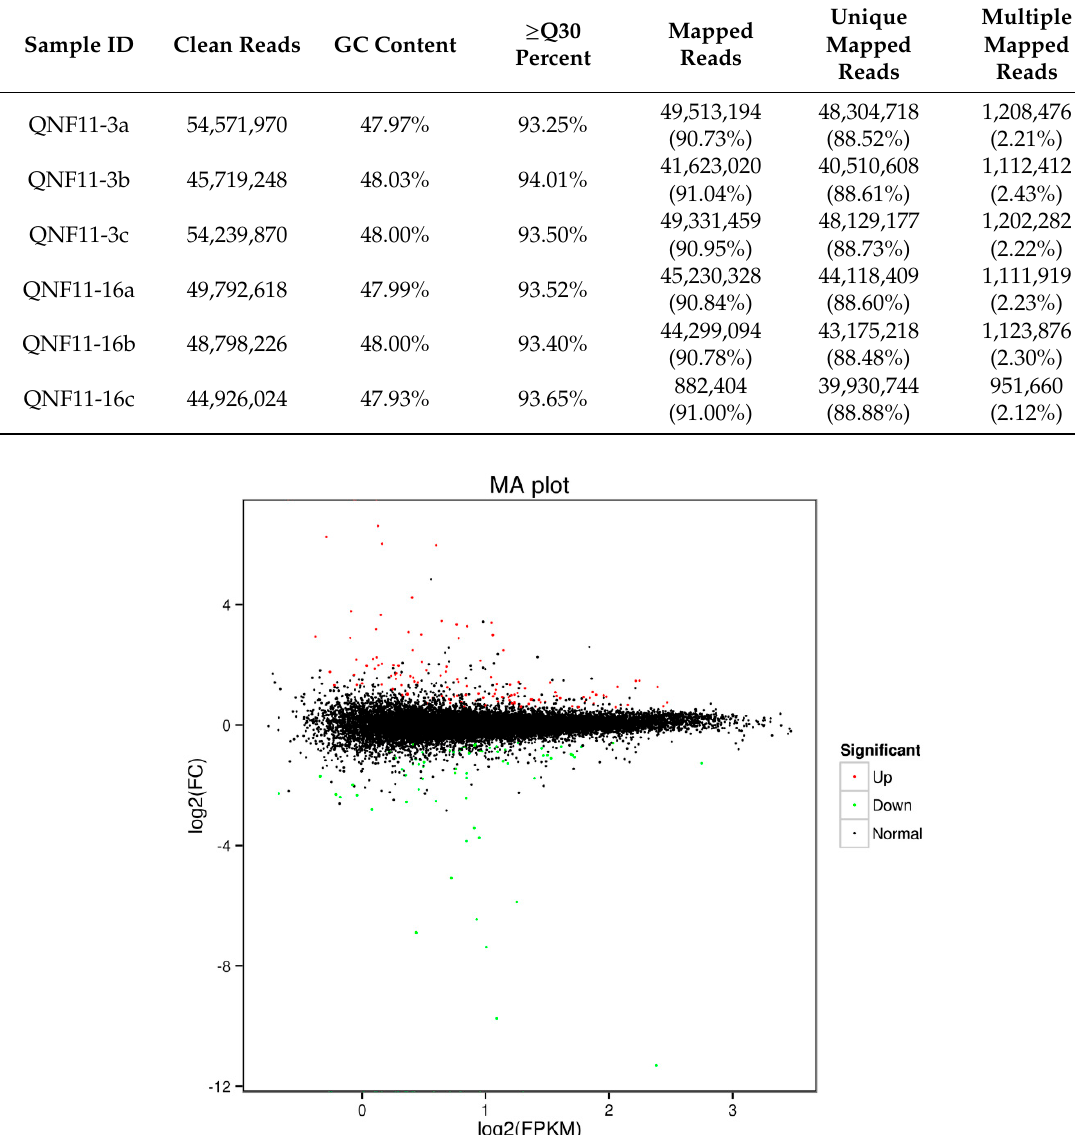
Figure 3. Scatter diagram of the differentially expressed genes. The green dots represent downregulated genes, the red dots represent upregulated genes, and the black dots represent non-differentially expressed genes.